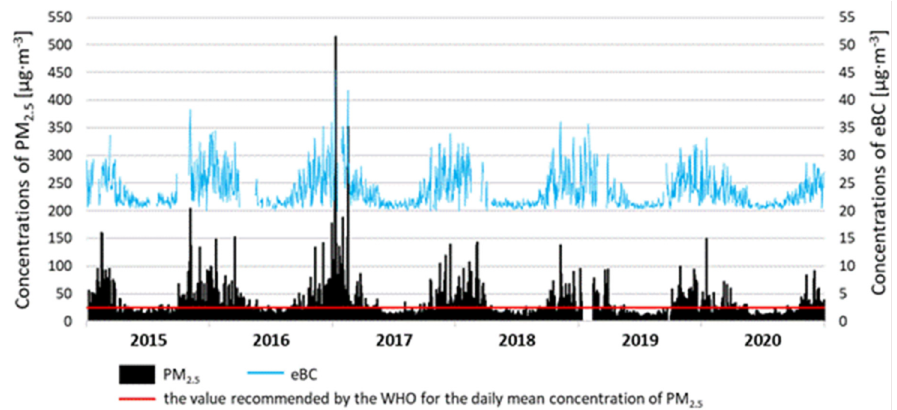
Figure 7. Seasonal course of eBC concentrations ( µ g · m − 3 ) recorded for the heating and non-heating season (the actual eBC concentrations have been increased by 20 to improve the readability of the